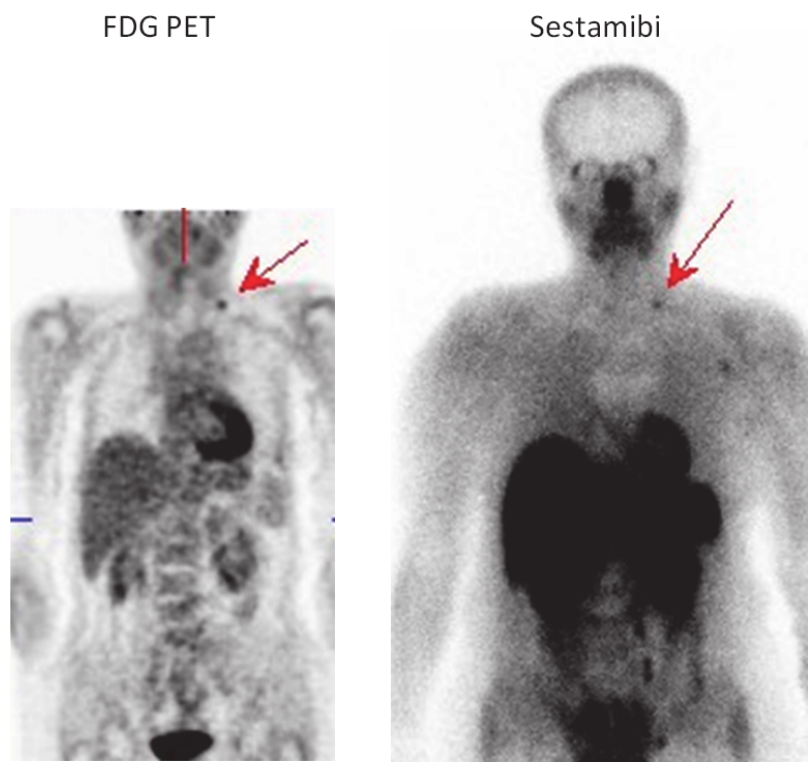
Fig. 3. Visualization of solitary cervical lymph node metastasis by [ 18 F] fluorode- oxyglucose positron-emission tomography and 99m technetium-sestamibi scan. After thoracoscopic resection of the lung metastases, control FDG PET (left) and 99m tech- netium-sestamibi scan (right) showed solitary metastasis in a left neck lymph node (January